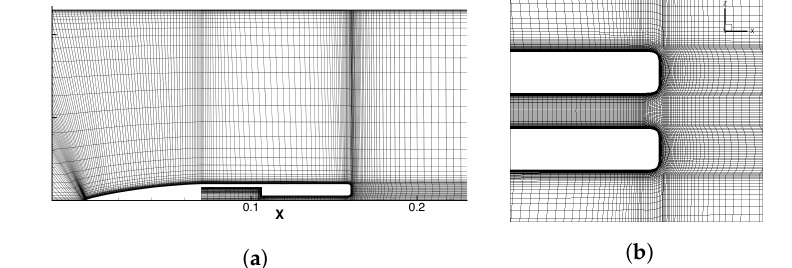
Figure 2. Detail of the grid spatial discretization used on the numerical analysis. General view ( a ) and trailing edge mesh details ( b ). Image partially reproduced from Martinez-Cava et al. [19].